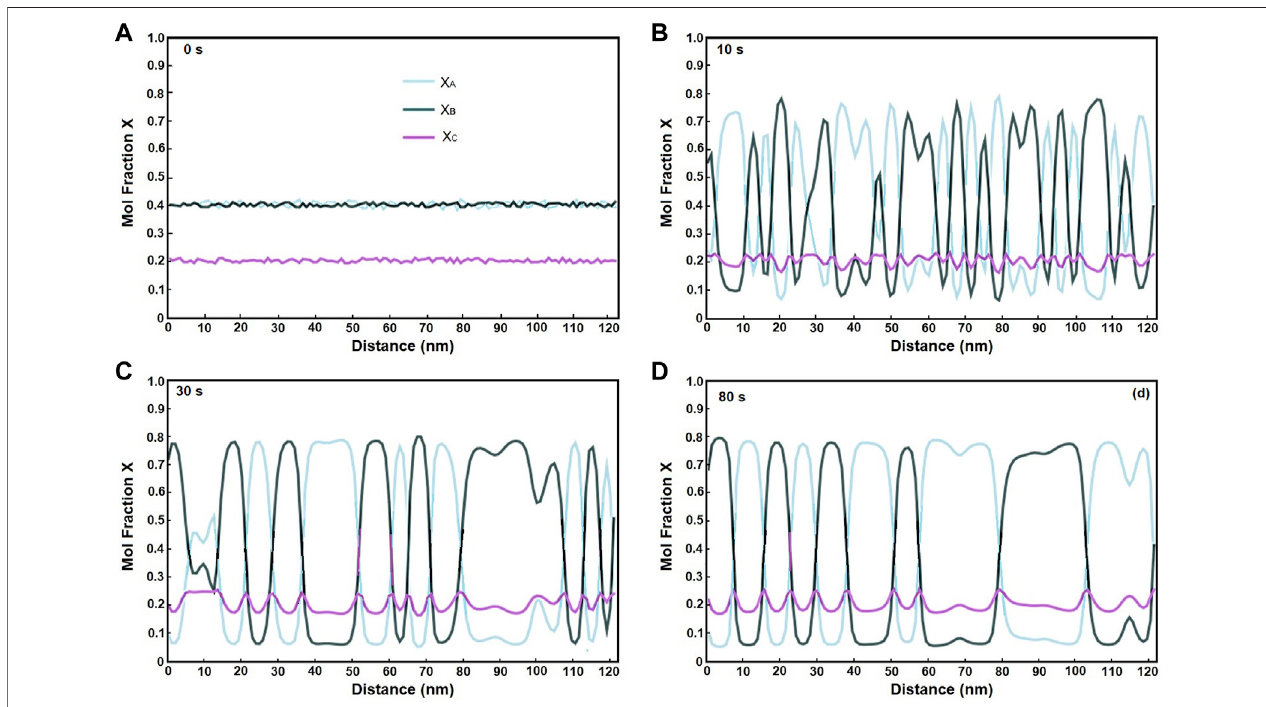
FIGURE 11 | Simulated concentration pro fi les of the A – B – C alloy for case IV with X A = 0.40 , X B = 0.40 , and X c = 0.20 aged at 800 K for (A) 0 s, (B) 10 s, (C) 30 s, and (D) 80 s.